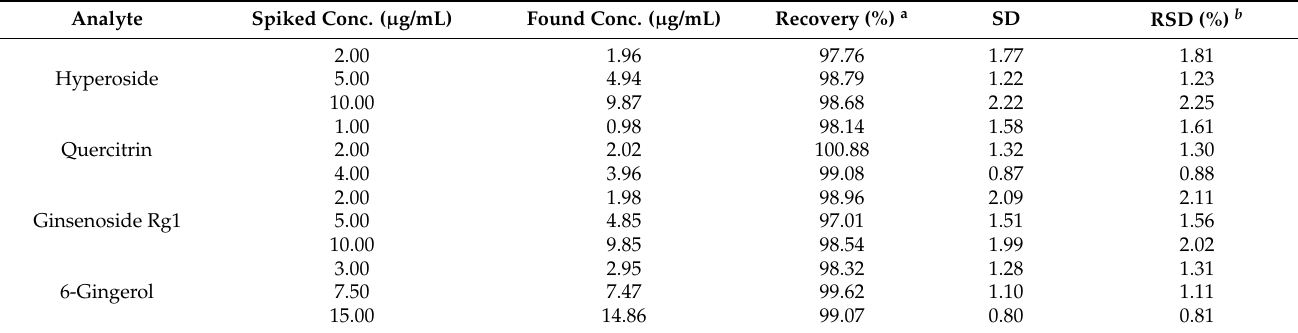
Table 2. Verification of the extraction recovery (%) of the analysis method developed using the four marker analytes ( n = 5). Analyte Spiked Conc. ( µ g/mL) Hyperoside